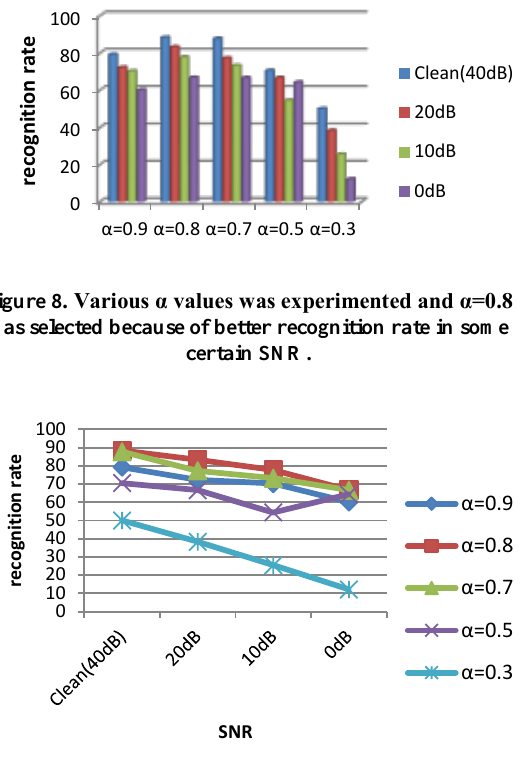
Figure 9. Results which depict that α=0.8 has the best speech recognition